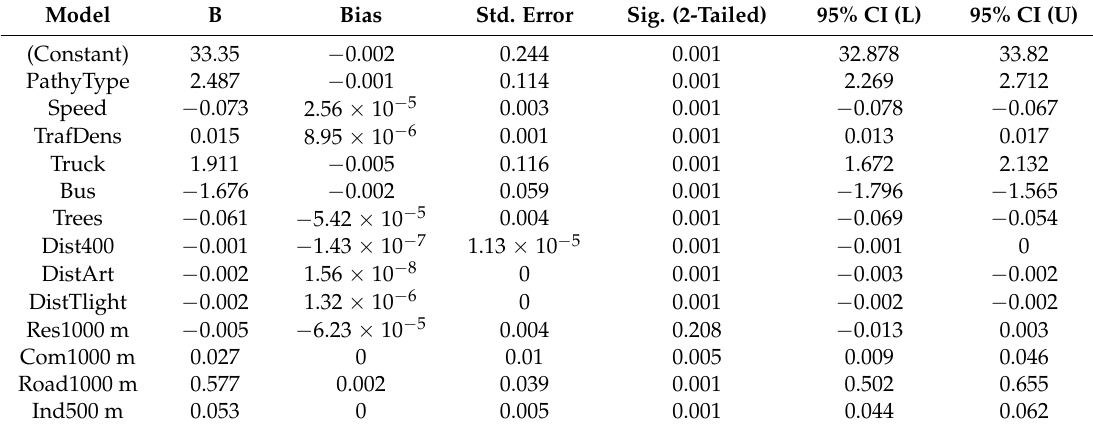
Table A3. Day4: Bootstrap for